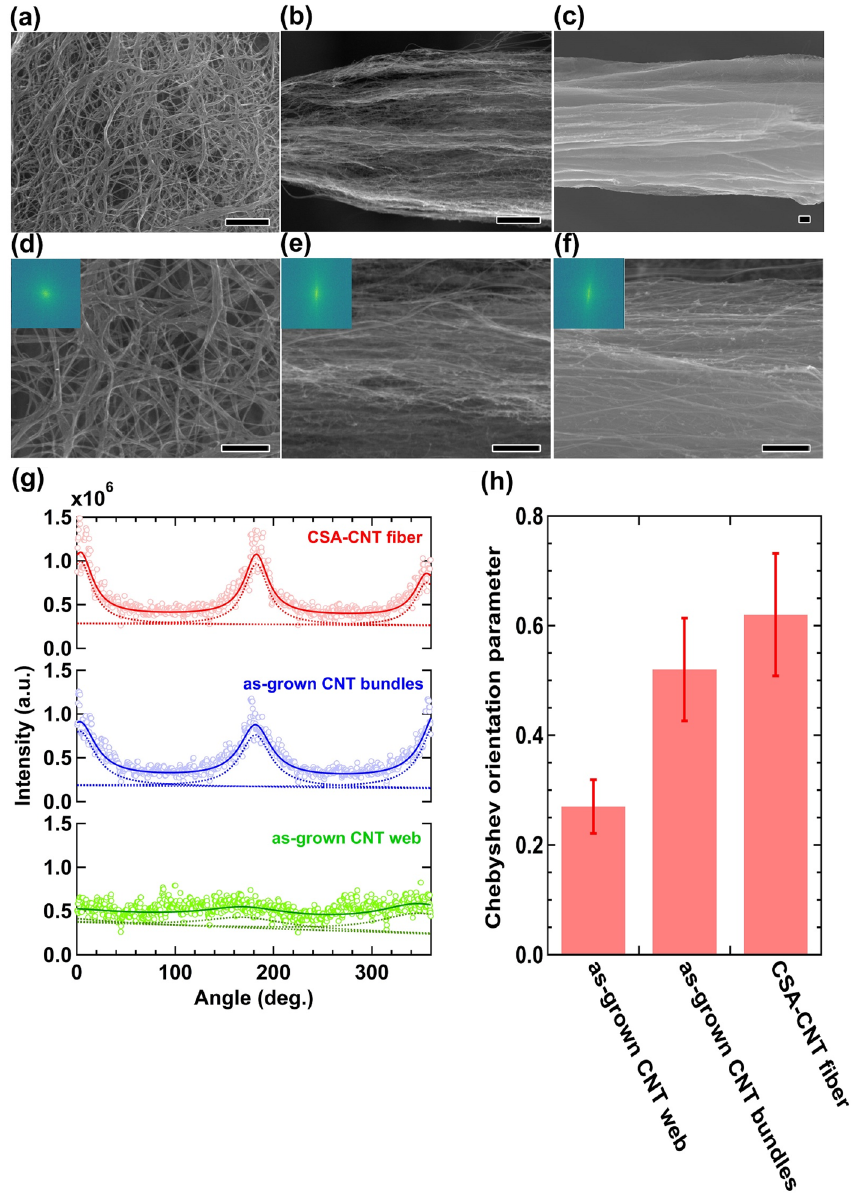
Figure 4. SEM images of ( a , d ) an as-grown CNT web, ( b , e ) an as-grown CNT bundles, and ( c , f ) a CSA-CNT fiber. Insets in ( d – f ) show the corresponding power spectra. Scale bar in ( a – c ): 1 μm. Scale bar in ( d–f ): 500 nm. ( g ) Angular intensity distributions of the CNT samples, obtained from the power spectra shown in ( d – f ). Fitting lines with the Lorentzian function and individual fits are depicted by the solid lines and the dotted lines, respectively. ( h ) Chebyshev orientation parameters of the CNT samples evaluated by the FFT image